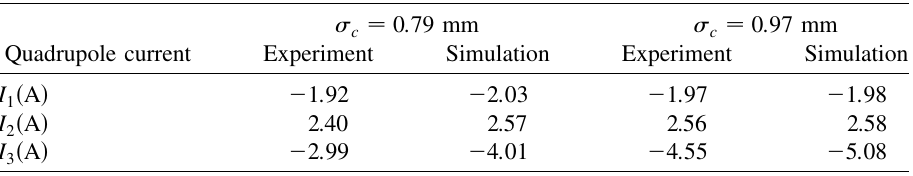
. I is the current of the skew quadrupole S c i